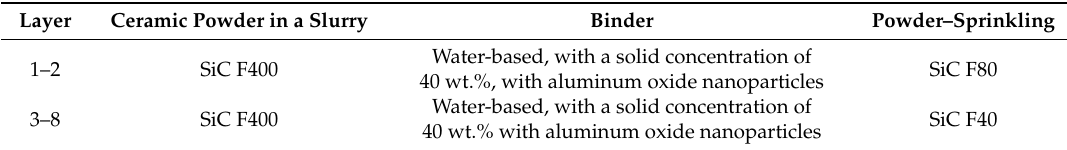
Table 1. Composition of slurries for SiC-based shell molds.